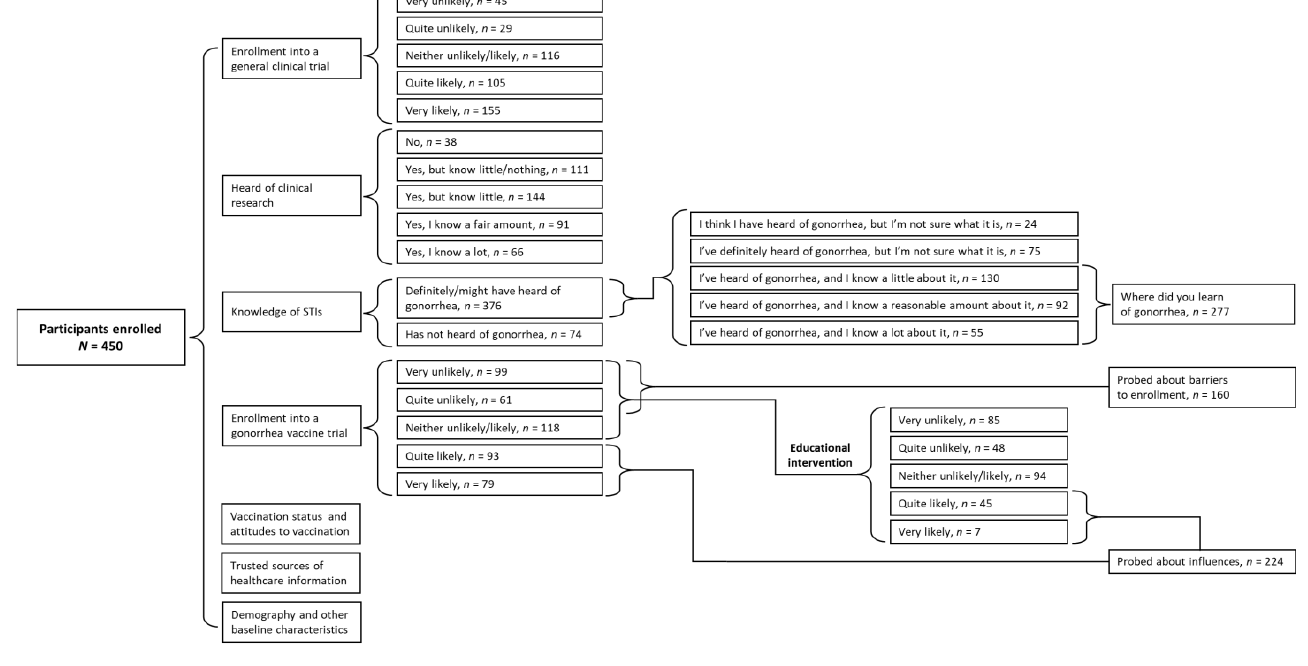
Figure 2. Dataset analyzed in this survey. Table 1. Participant characteristics ( N =